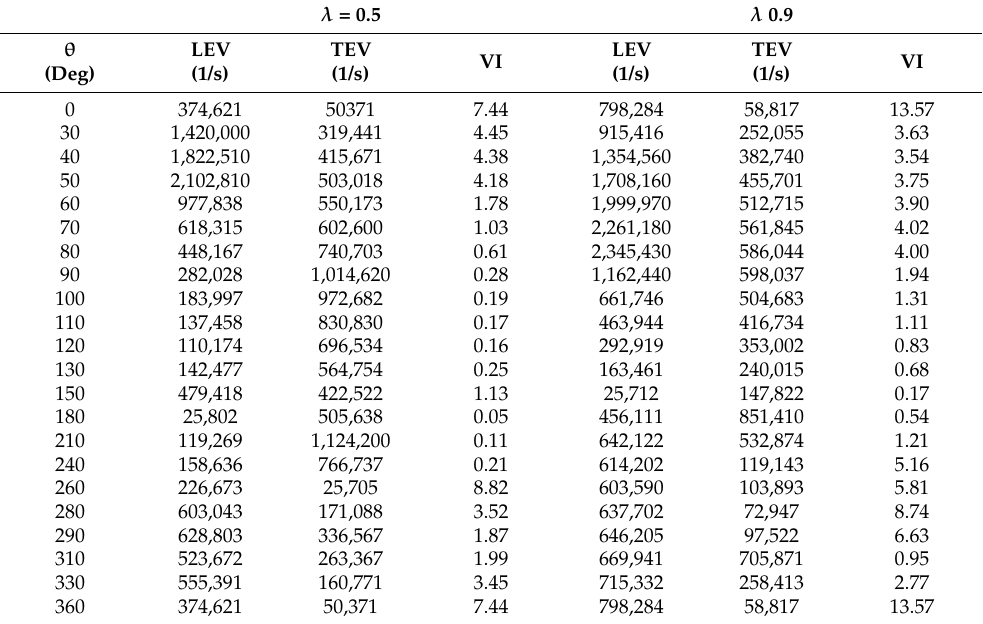
Table A2. Vorticity at the Leading Edge (LE) and Trailing Edge (TE) and VI for Blade 1 at Various Azimuthal Angles for U ∞ = 20